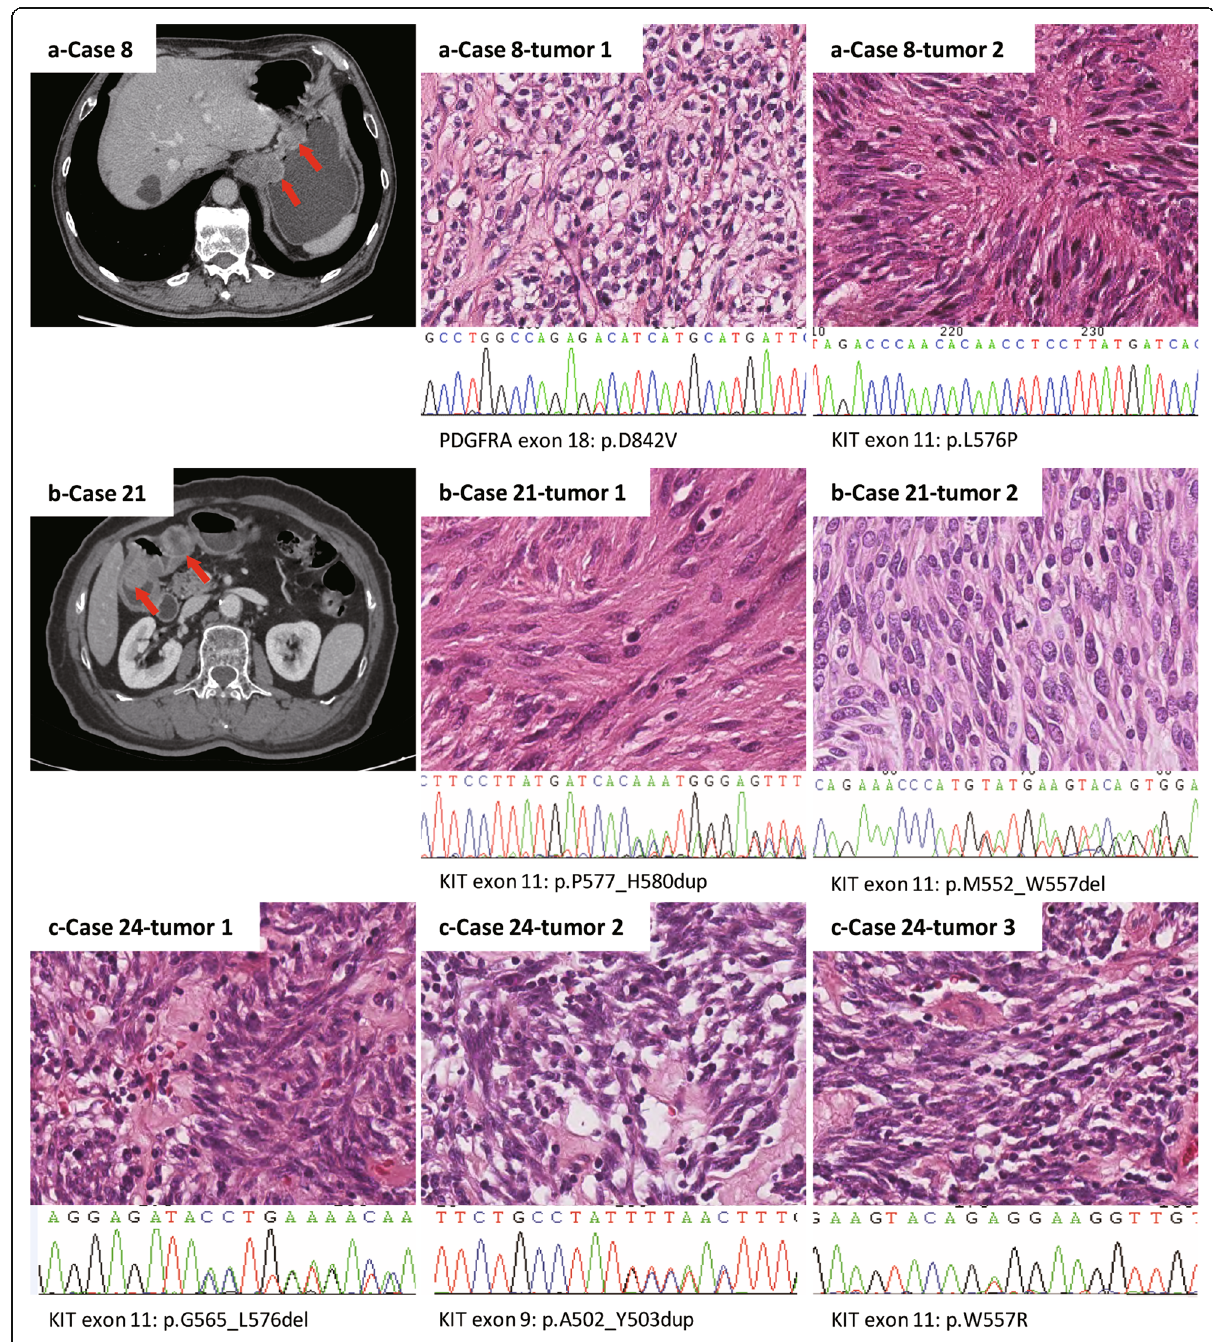
Fig. 2 a A CT scan shows (red arrow) that there are two distinct GIST lesions in the stomach (case 8 in Table 1). The histological features and genetic types of the two lesions were different. The tumor cells in the first tumor were epithelioid, with the PDGFRA D842V mutation, while those in the second tumor were spindle shaped, with the KIT L576P mutation. b A CT scan shows (red arrow) two lesions of the same GIST patient (case 21 in Table 1). Although the tumor cells were spindle shaped, the cell density, atypia, mitosis and genetic types of the two lesions were different. c shows no difference in histological features among the three lesions from the same patient (case 24 in Table 1), but the genotypes of the three lesions were not the